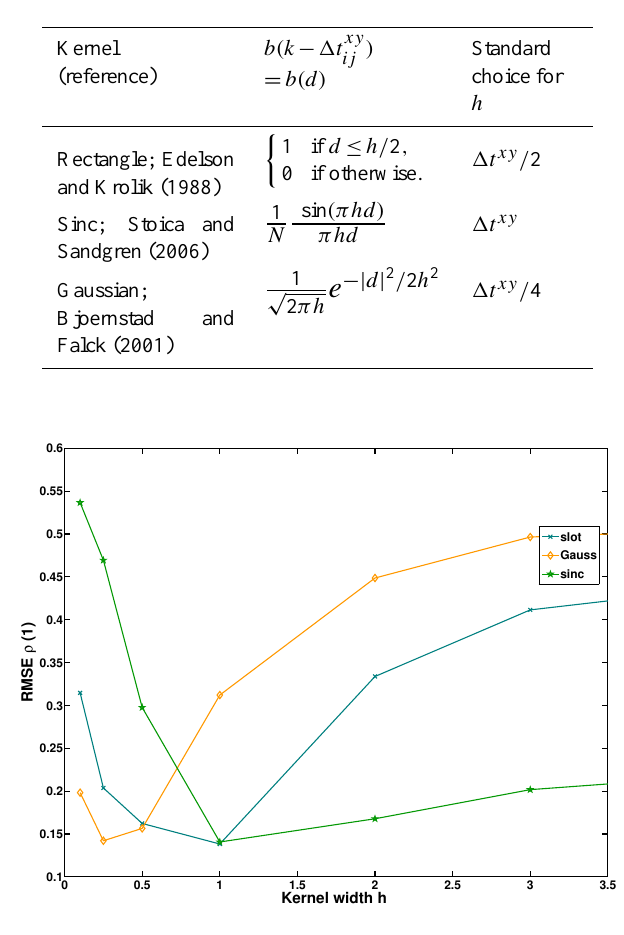
Fig. 3. Influence of varying kernel width h on the RMSE of ρ( 1 ) , using the kernel estimators (cf. Table 1, Fig. 2). 100 Realizations of sinusoids with random phase in colored noise (30%) were sampled using 0 − distributed sampling intervals (sk=2.85). (cf. Sect.